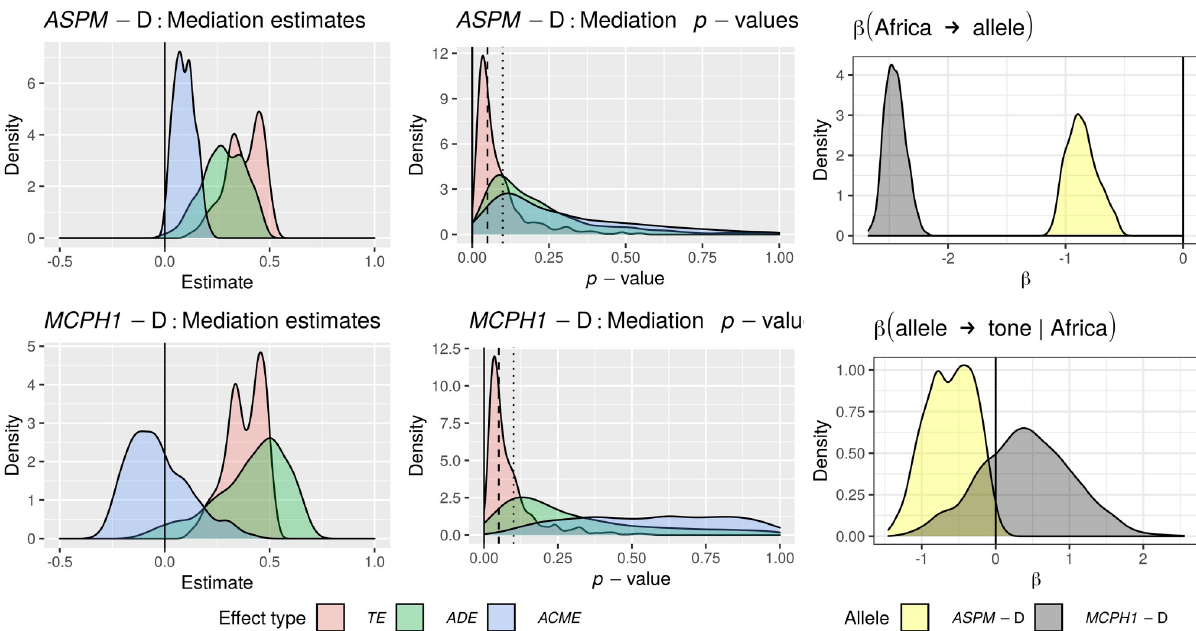
Fig 11. Mediation analysis for 1,000 restricted samples for tone1 . The leftmost two panels show the distribution of point estimates (coloured areas) of the Total Effect ( TE ), the Direct Effect ( AD E) and the Indirect Effect ( ACM E) for ASPM -D and MCPH1 -D; the middle two panels show the distribution of the p -values (coloured areas) for the same effects, while the two rightmost panels (on white background) show the distribution of the regression slopes ( β ) for the two alleles (top: for the regression of the allele frequency on being within or outside Africa, and bottom: for the regression of tone on the allele while controlling for being within or outside Africa). The black vertical lines are: 0.0 (solid), 0.05 (dashed) and 0.10 (dotted). Please note that the y-axes vary between plots, but the x-axes of the four left panels (but not of the two right panels) are fixed for comparability. Mediation estimates (leftmost panels): ACME (blue) should be away from 0 for a sizeable mediation through the “derived” allele. Mediation p -values (mid panels): ACME (blue) should be below 0.05 (or 0.10) for a statistically significant mediation through the “derived” allele. (Partial) regression slopes β (rightmost panels): should be different from 0. See Table 9 for the numeric summaries.